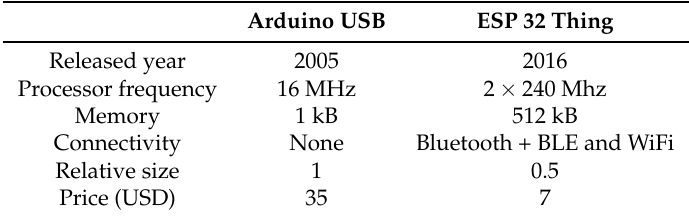
Table 1. Arduino USB and ESP 32 comparison. BLE: Bluetooth Low Energy.